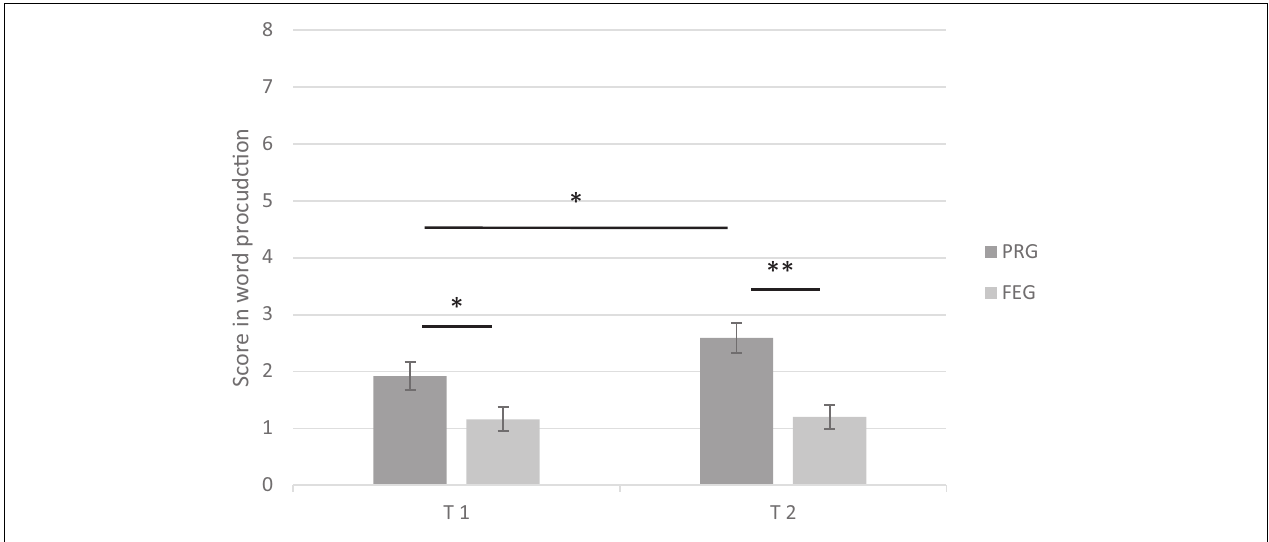
FIGURE 6 | Children’s word production score ( SE ) at the first (T1) and second (T2) testing. PRG = progressively reduced iconic gestures; FEG = fully executed iconic gestures; children could score 8 points in both conditions, * p < 0.05, ** p < 0.01, *** p < 0.001. TABLE 2 | Mean score, standard deviation ( SD ), and difficulty for each item (target word) in the PRG and FEG condition (PRG = progressively reduced iconic gestures; FEG = fully executed iconic gestures). Ralle Alk Fennek Beisa “auk” “fennec”